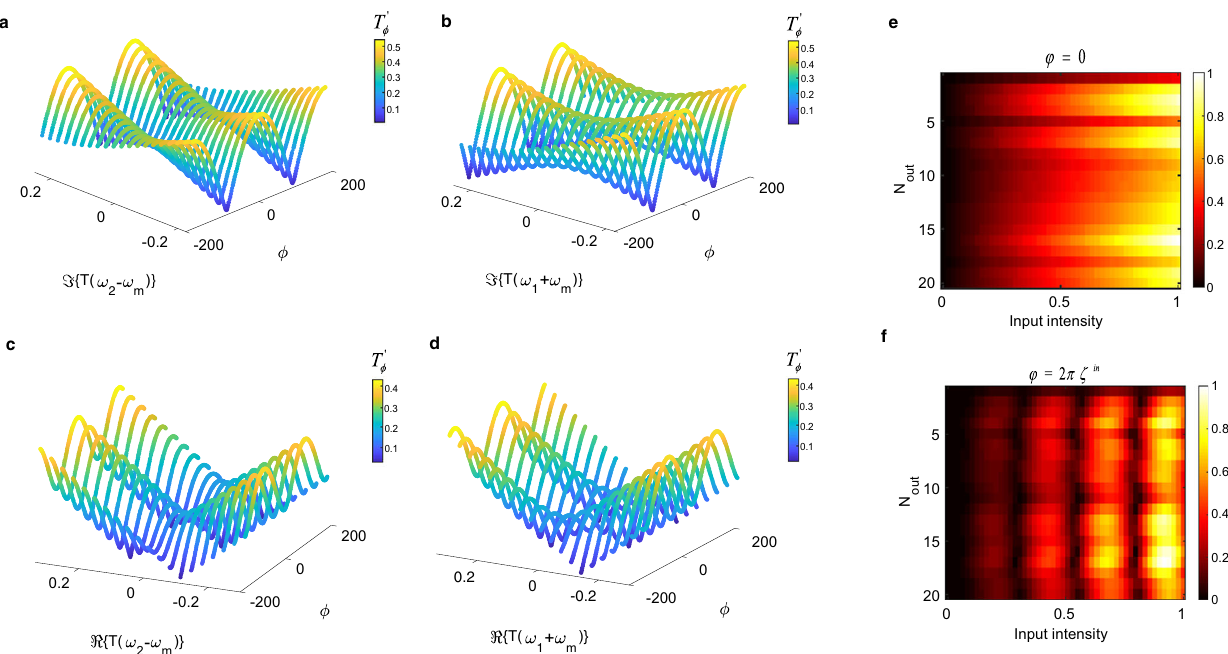
Fig. 2 Nonlinear Floquet entanglement. a – d Theoretical demonstration of the nonlinear dependency of the intensity T 0 ϕ of the central Floquet harmonic ( ω = ( ω 1 + ω 2 )/2) on both the modulation phase ϕ and the real or imaginary part of one of the generated harmonics. The results are based on Eq. 7. The fi xed parameters for a – d are: a T ( ω + ω m ) = 0.1 − 0.25 i and ℜ { T ( ω − ω m )} = 0.1. b T ( ω − ω m ) = 0.1 − 0.25 i and ℜ { T ( ω + ω m )} = 0.1. 1 2 2 1 c T ( ω 1 + ω m ) = 0.1 − 0.05 i and ℑ { T ( ω 2 − ω m )} = 0.05. d T ( ω 2 − ω m ) = 0.1 − 0.05 i and ℑ { T ( ω 1 + ω m )} = 0.05. e , f The numerical demonstration of linear/nonlinear Floquet entanglement for the central harmonic wave for different readout nodes in terms of input intensity, for static ( e ) and dynamic phase delays ( f